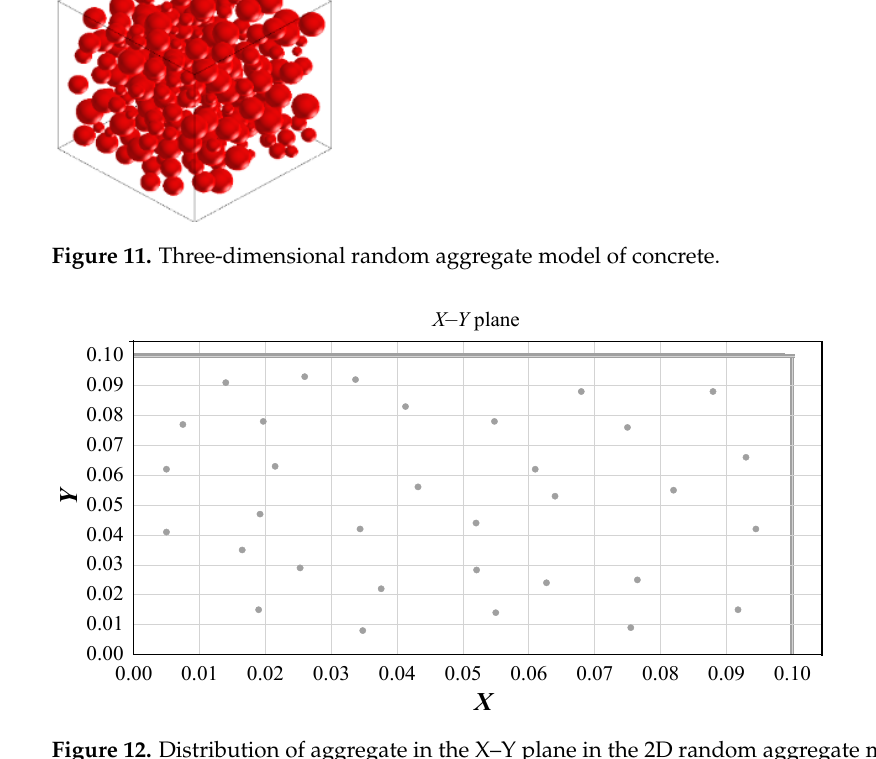
Figure 12. Distribution of aggregate in the X – Y plane in the 2D random aggregate model.